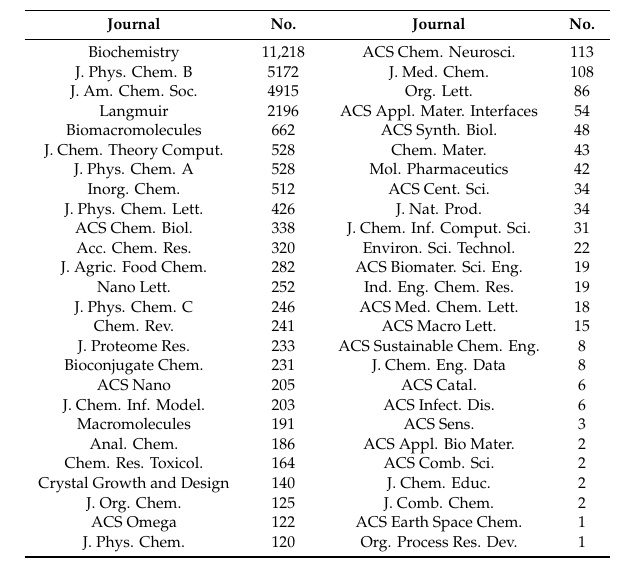
Table 1. Number of biochemical papers published by